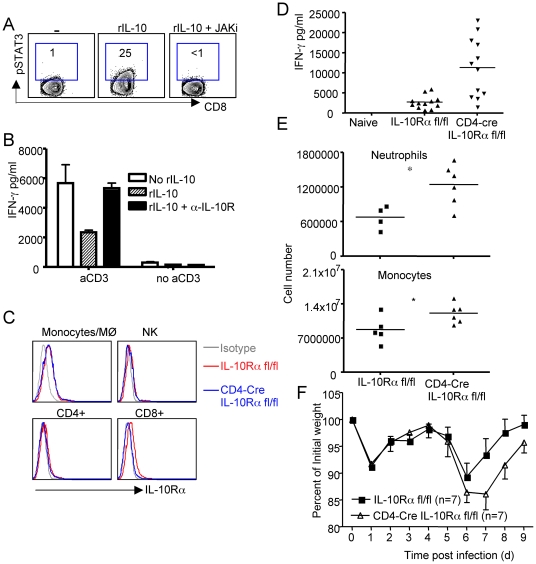
Autocrine regulation of pulmonary inflammation by effector T cell-derived IL-10 during RSV infection.(A, B). BALB/c mice were infected with RSV. At d7 p.i., Lung CD8+ cells were purified and stimulated as indicated in vitro. (A) CD8+ T cells were stimulated with rIL-10 in the absence or presence of JAK inhibitor. STAT3 phophorylation was determined by ICS. (B) CD8+ T cells were left un-stimulated or stimulated with plate-bound a-CD3 overnight in the absence or presence of rIL-10 or rIL-10 plus α-IL-10R. IFN-γ release to the medium was determined by ELISA. (C – F) IL-10Rα fl/fl mice or CD4-Cre+ IL-10Rα fl/fl mice were infected with RSV. (C) The expression of IL-10Rα in lung monocytes, NK cells, CD4+ and CD8+ T cells at d6 post infection was determined by flow cytometry. (D) IFN-γ levels in the BALF were determined by ELISA. P value was determined by unpaired two-tailed Student t test. * indicates P< = 0.05. (E) Lung infiltrated neutrophils and inflammatory monocytes were determined by flow cytometry. P value was determined by unpaired two-tailed Student t test. * indicates P< = 0.05. (F) Mouse weight loss was monitored daily following infection. A, B, C. Data are representative of at least two independent experiments. D, E .Pooled data from four experiments are represented. F. Pooled data from three experiments are represented.